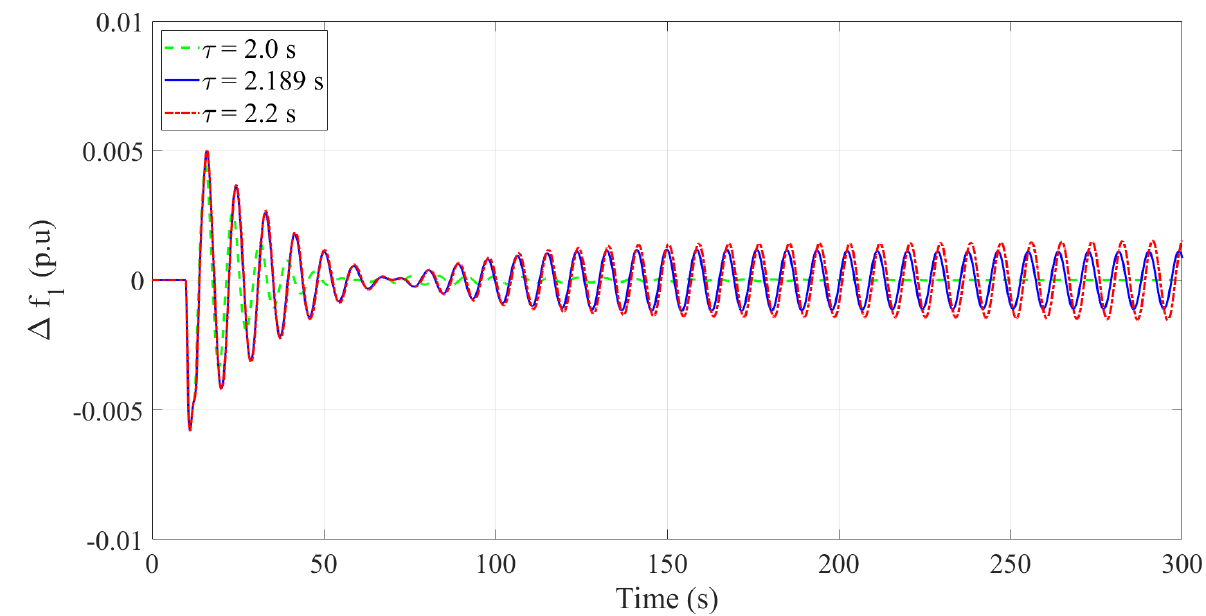
Figure 13. Frequency deviation for LFC − 1: ∆ f 1 was measured while using K P = 0.4 and K I = 0.6.